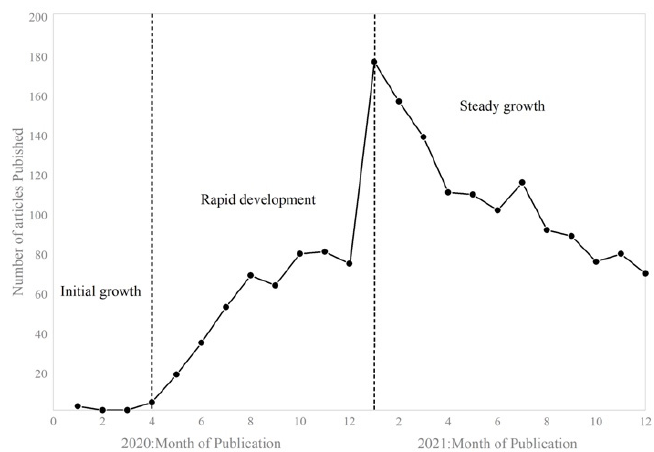
Figure 2. The number of publications in the past two years.